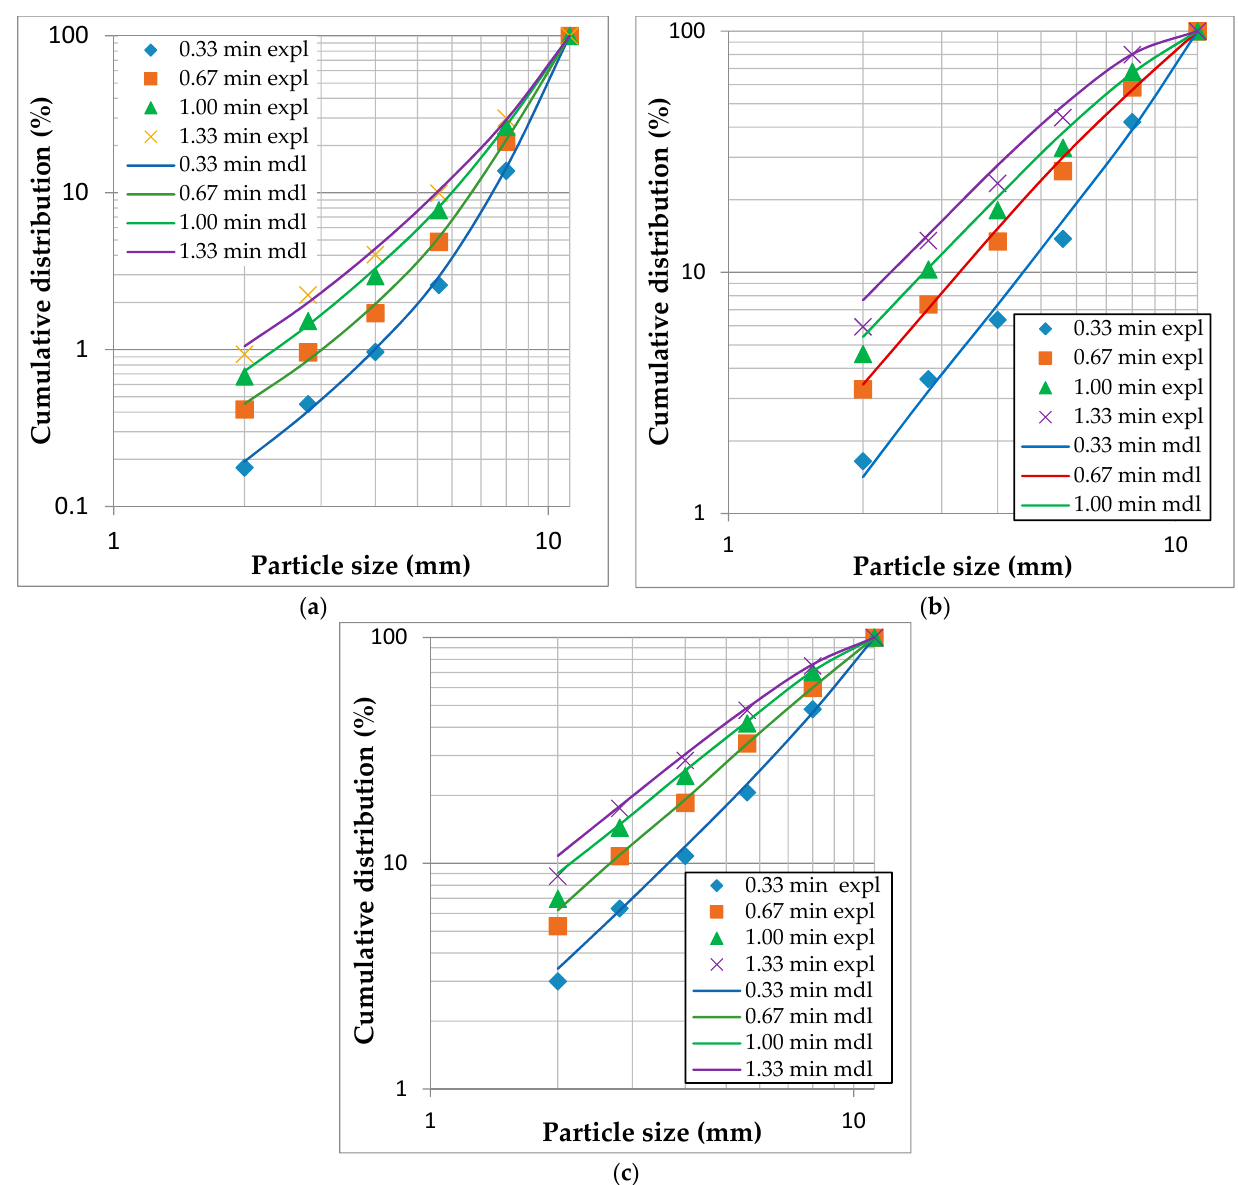
Figure 6. Measured and predicted particle size for rotor speeds ( a ) 510 rpm, ( b ) 885 rpm, and ( c ) 1040 rpm for feed size -13.2 +11.2 mm.